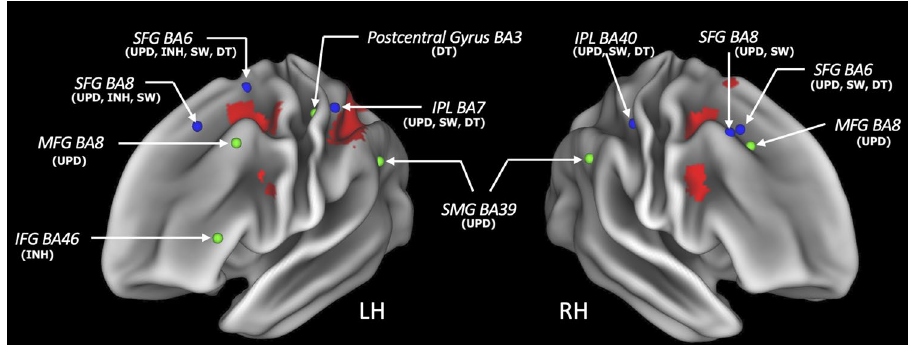
Figure 5. An illustration of areas corresponding to absolute (green spheres) and relative diversity (blue spheres). Unity areas are shown in red and correspond to those shown in Fig. 2. The coordinates of these locations were taken from the regions indicated in Figs. 3 and 4. Note that some coordinates for relative diversity on the medial wall such as thalamus (BA50) and precuneus (BA 7) are not shown here for